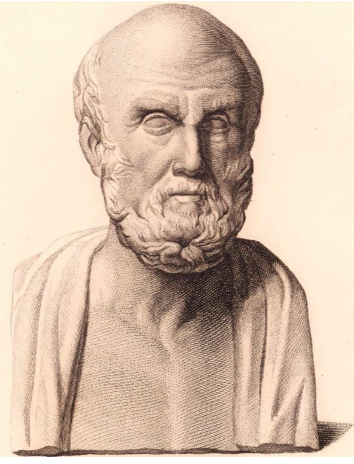
Figure 8. (Hippocrates of Kos; c.